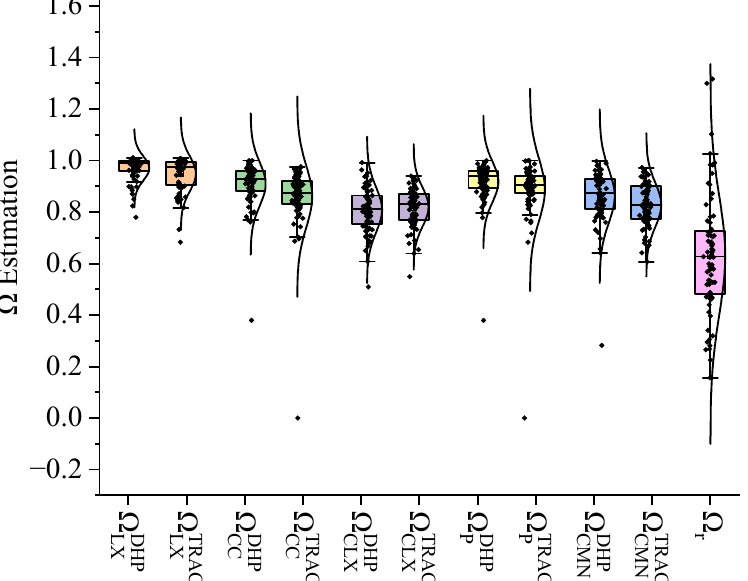
Figure 4. Comparison of CI estimation values using different methods. (Note: the black curve on the right indicates that the data are normally distributed.)